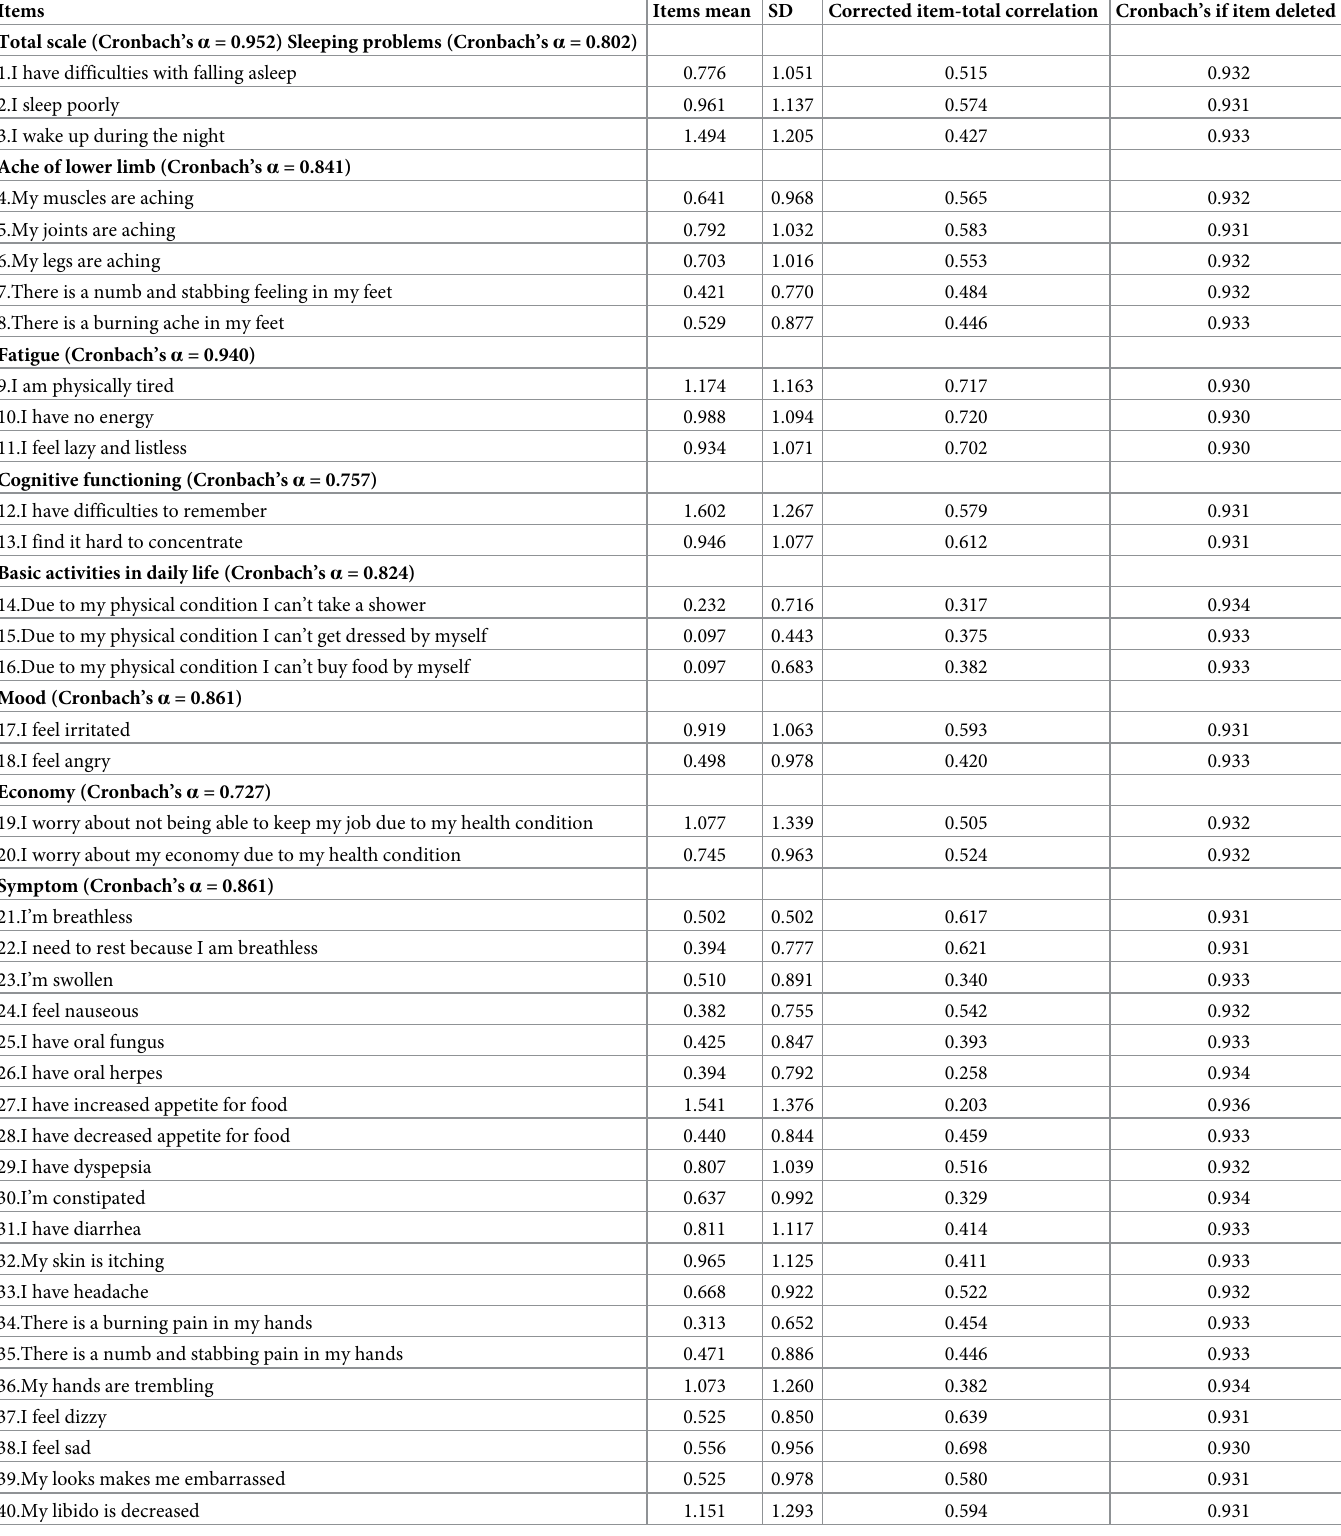
Table 1. Organ Transplant Symptom and well-being instrument: Item analysis. Items Items mean